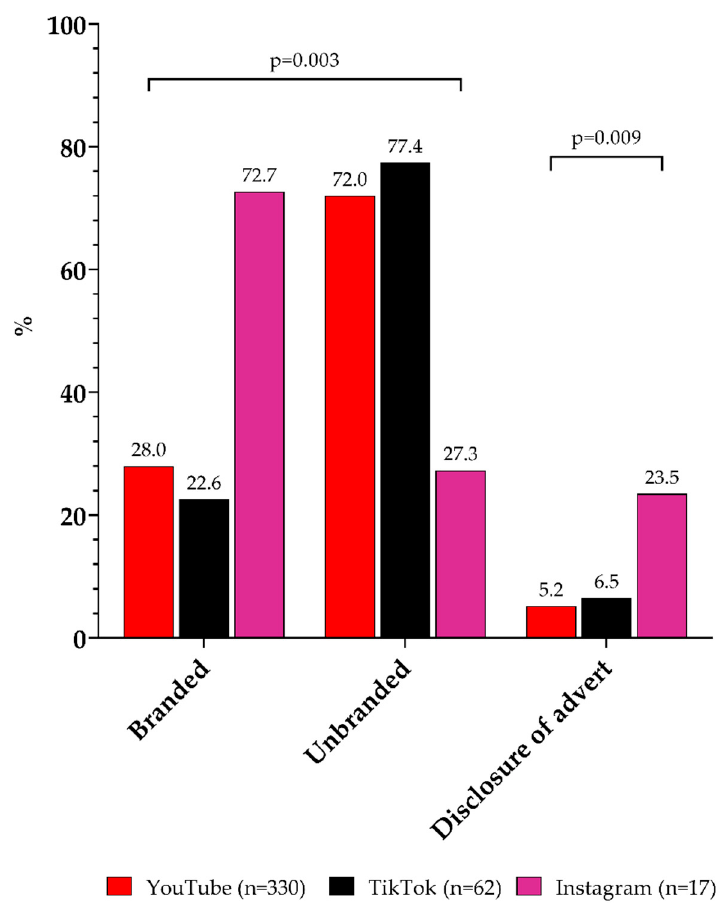
Figure 2. Statement of food and beverage product or brand and disclosure of advert in the video itself and/or video description according to the platforms. Note: Significant differences were calculated using chi-squared test.